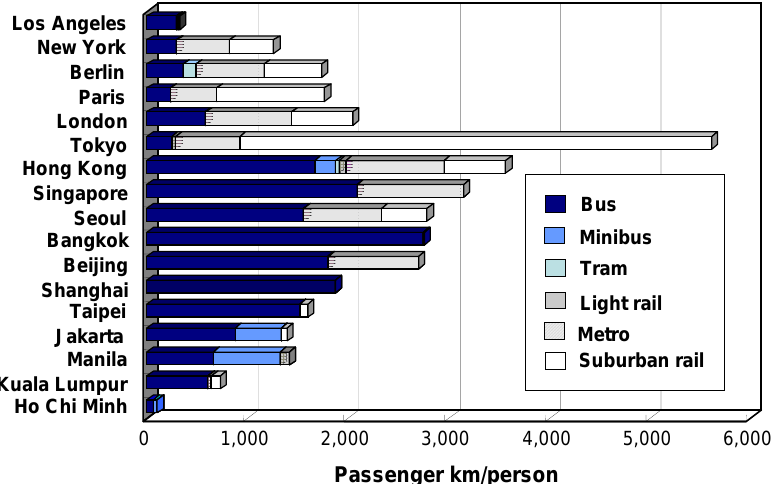
Figure 5. Per capita passenger-km of public transport in some selected